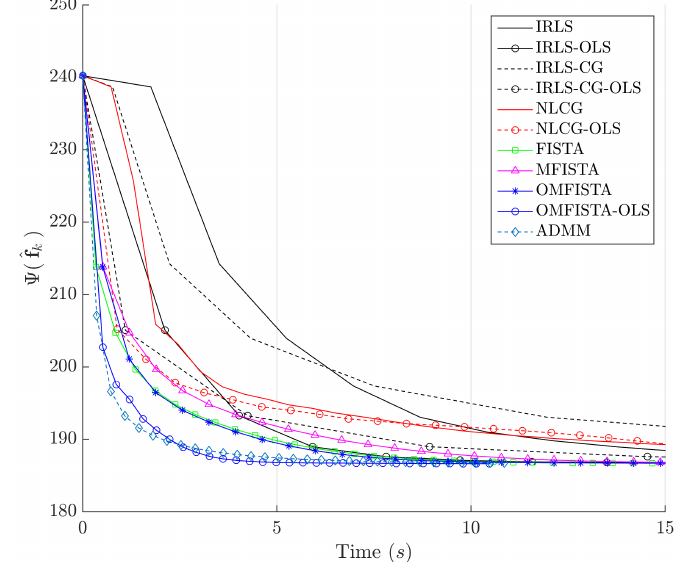
Figure 23. Cost function Ψ ( ˆ f k ) versus time in seconds—Distinct real